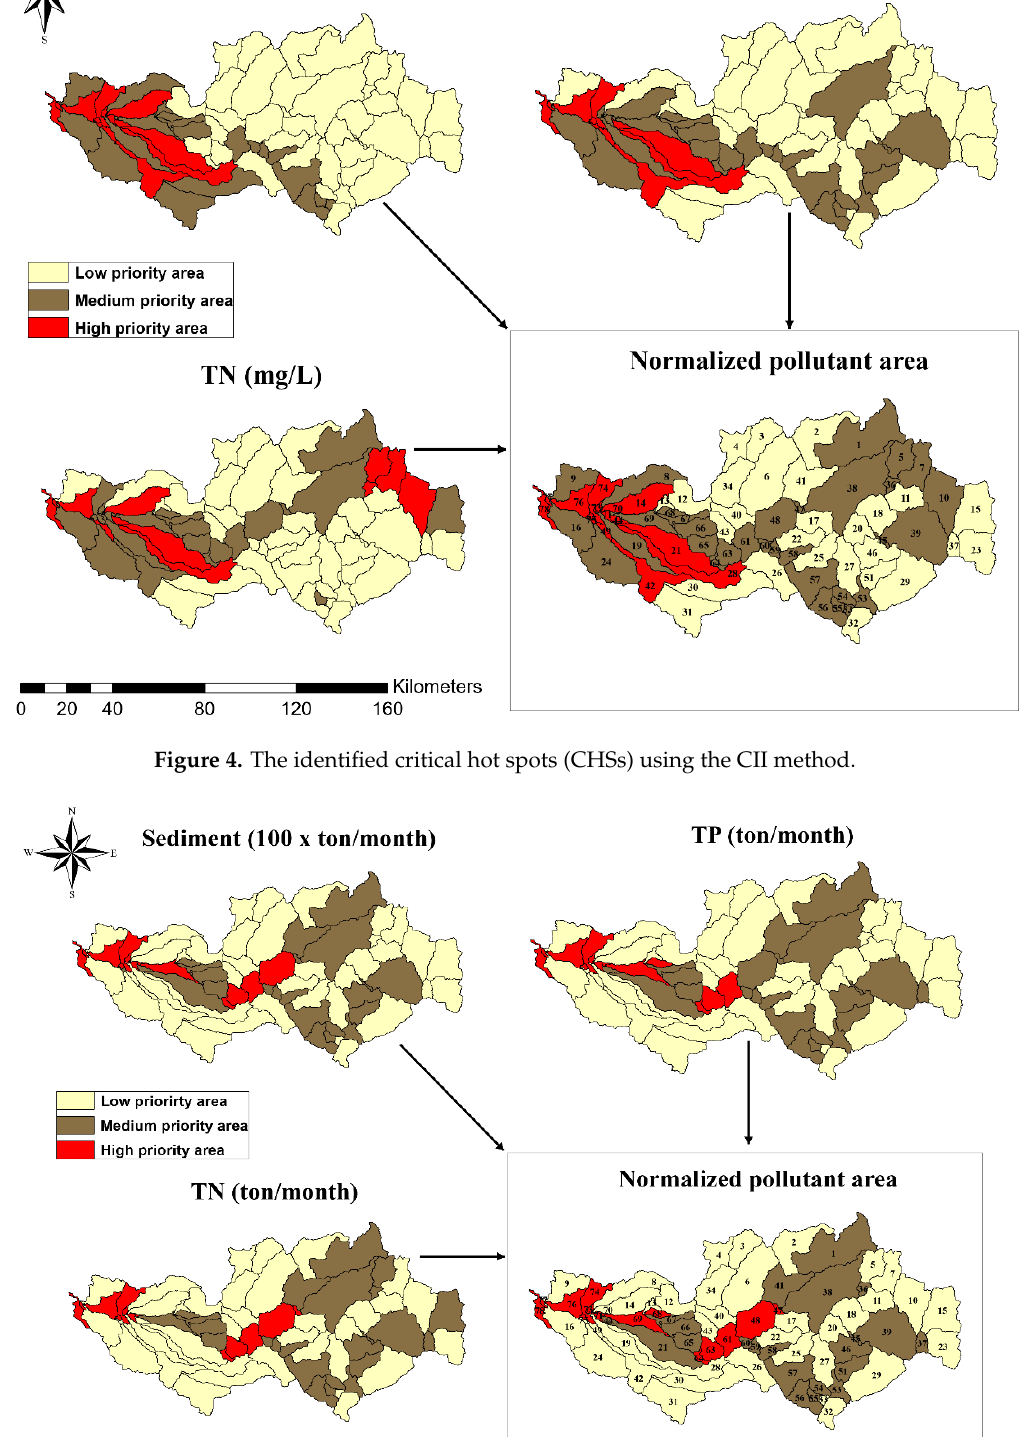
Figure 6. The identified critical hot spots (CHSs) using the LPSAI method. 3.4. The Suitable LID/BMP Choice for CHSs For the identified CHSs above, a decision process to select the best suitable LID/BMP option was carried out based on three different management schemes (EE, EFW, EW) using the AHP structure. The pairwise comparison matrices for CII, LII, and LPSAI are generated as a function of the reduction rate of sediment and nutrient concentration at each sub-watershed level. Table 7 shows one example